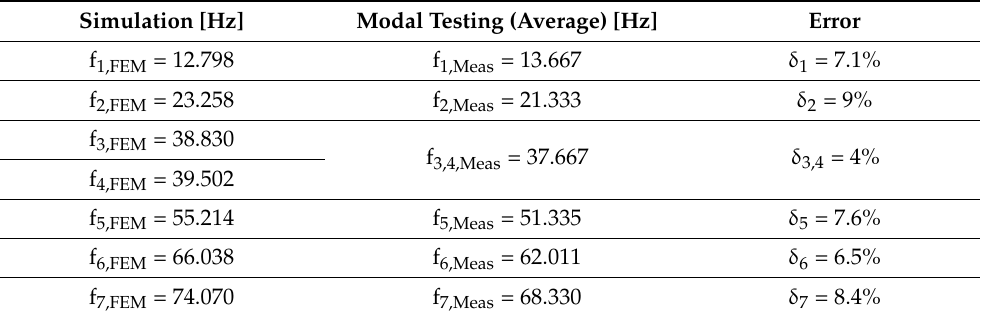
Figure 15. The meshed model with the springs at the corners. Further springs were added to each side at the x-y plane to prevent the rigid body motion, the eigenfrequencies in the z direction are the same. The results from the simulation are summarized by Table 5. Table 5. The results from the simulation and the modal testing. It seems that the third and fourth frequencies are too close to each other and it could not be seen in the FFT.